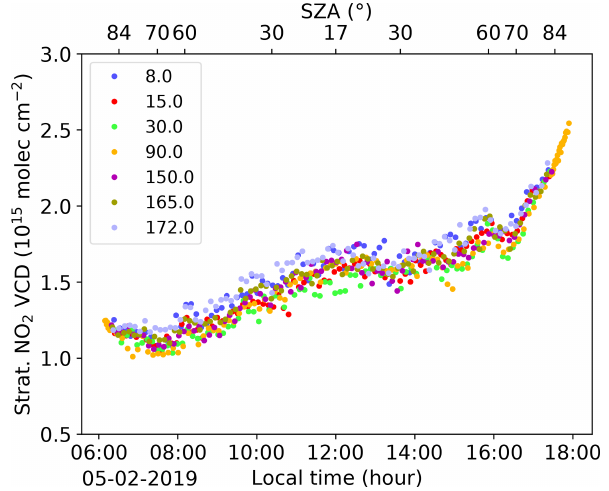
Figure 3. An example of 1d of tropospheric NO 2 VCDs on 24 June 2019. The NO 2 VCDs derived from different elevation an- gles are indicated with different colours. The reference spectrum was taken at the 90 ◦ elevation angle in every scan so that no NO 2 VCD was retrieved from the 90 ◦ elevation angle. The measurements were taken over the Pacific Ocean. At 12:00LT, RV Sonne was at 24.8 ◦ N, 136.1 ◦